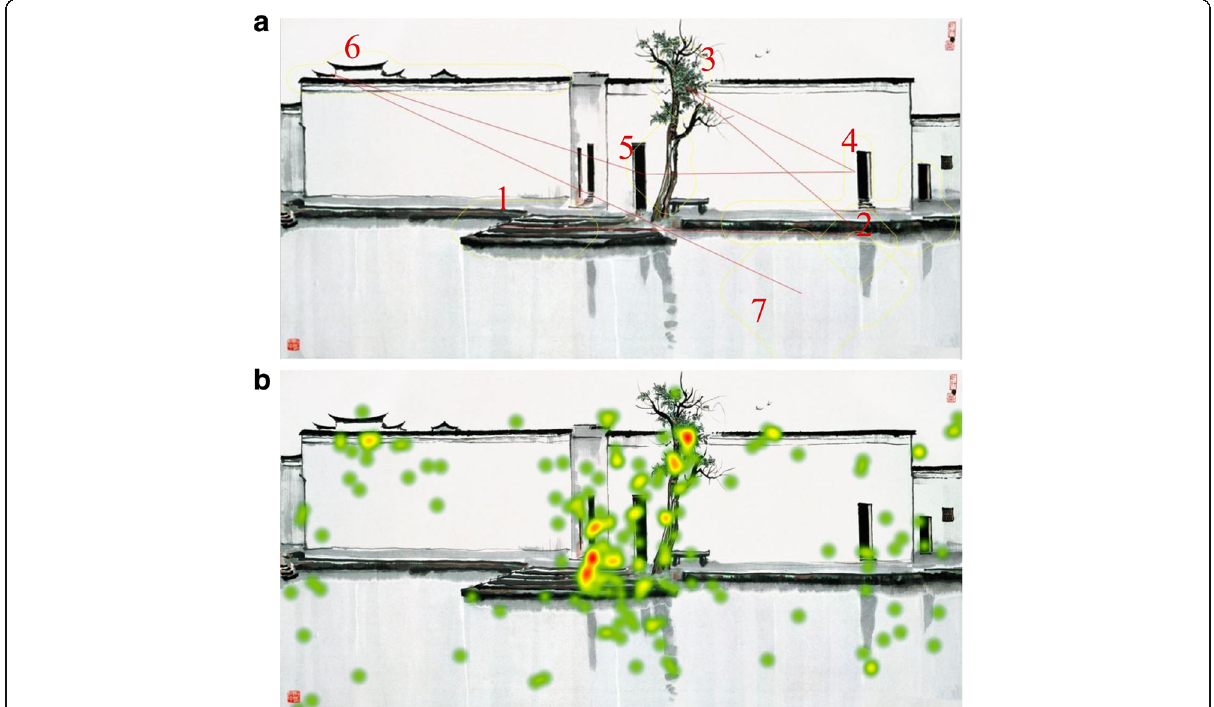
Fig. 7 Calculated saliency result of “ Twin Swallows ” ( a ) and heat map of eye movements on Wu Guanzhong ’ s “ Twin Swallows ” ( b )